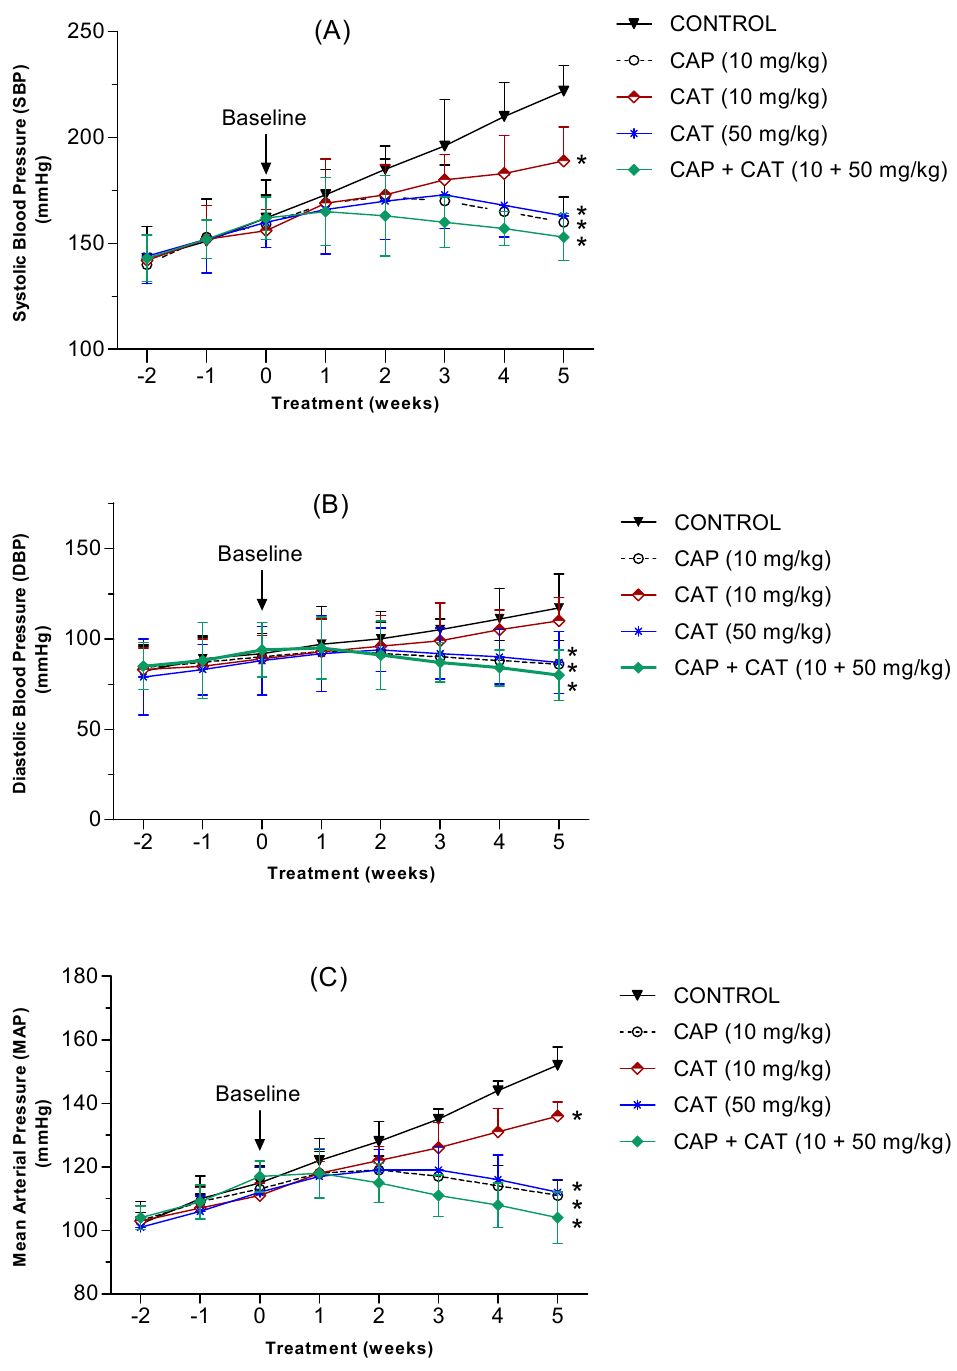
Figure 3. Effect of catechin (CAT) and captopril (CAP) on the systolic ( A ), diastolic ( B ), and mean arterial blood pressure ( C ) in male spontaneously hypertensive rats (SHR). Blood pressure was measured weekly for 5 weeks as described in the methods section. Data are presented as the mean ± SEM ( n = 6–9). * Significant difference from control group at 5 weeks, p < 0.05. Additionally, while DBP increased by +27% in the untreated control rats, a 5-week treatment with low and high CAT doses resulted in a change of +20% and − 1.6%, respec- tively (Figure 3B). Captopril monotherapy, on the other hand, resulted in a change in DBP by − 4.4%. Treatment with CAP or high dose CAT for 5 weeks normalized the rise in DBP